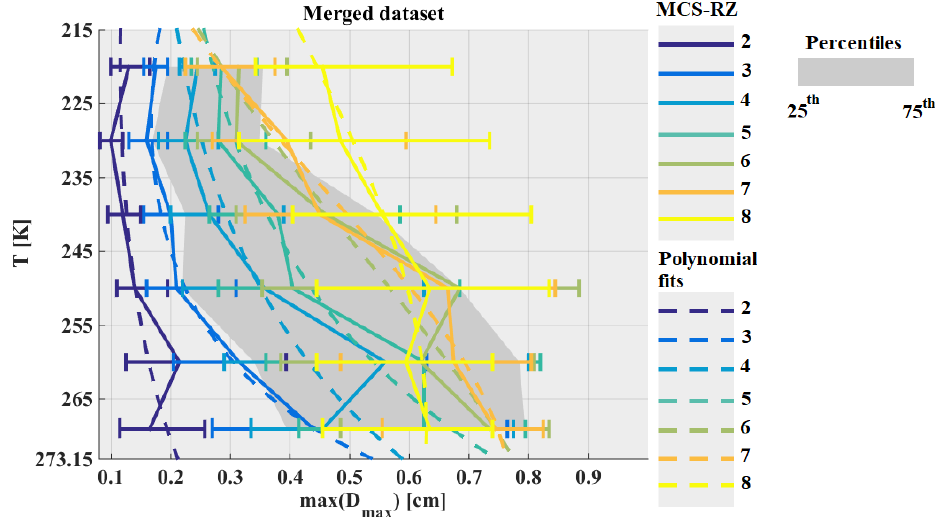
Figure 17. The same as Fig. 5 but for the maximum size of hydrometeors max (D max ) in PSD in cm.